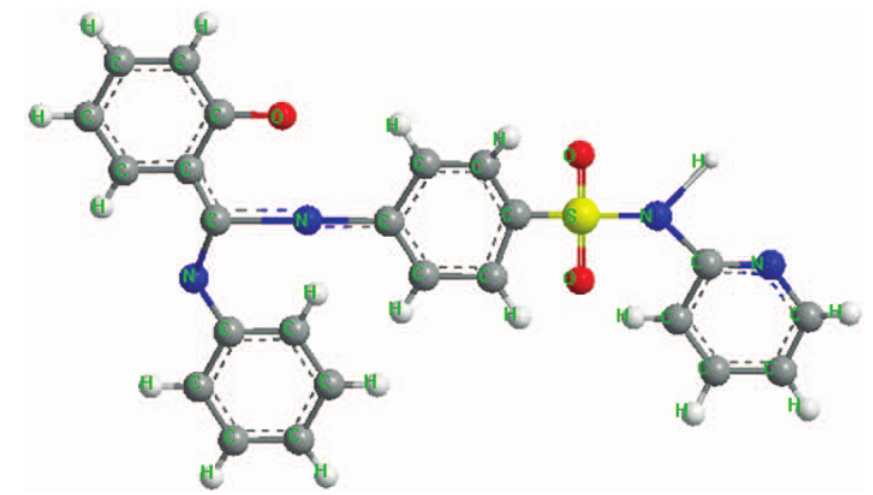
Figure 1 Structure of the ligand (salicylanilide